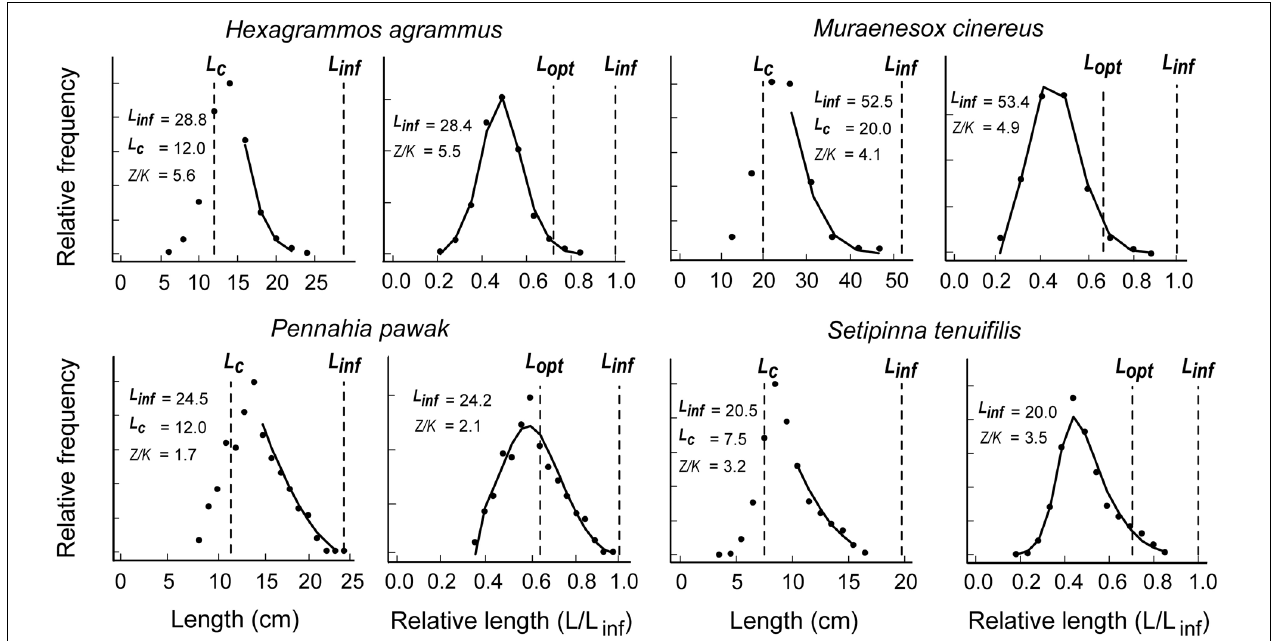
FIGURE 2 | Application of the LBB method to 4 species of commercially exploited fish along the coast of China and for with length-frequency data were obtained from Zhou and Xu (2007), Xiong et al. (2009), Yan et al. (2011), and Ji (2014); see also Table 1 and Supplementary Tables S1, S2